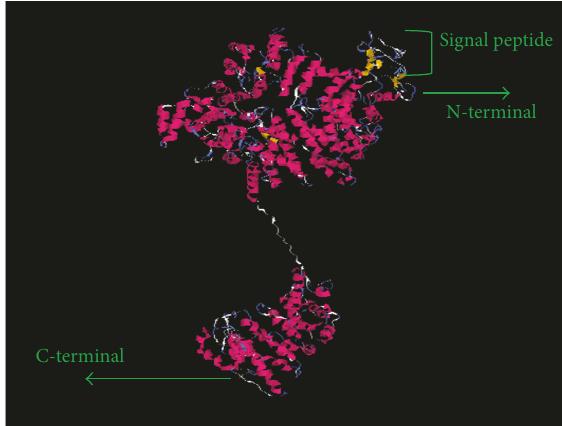
Figure 6: Babesia orientalis RON2 tertiary prediction structure . The predicted model with the highest C-score of B. orientalis RON2